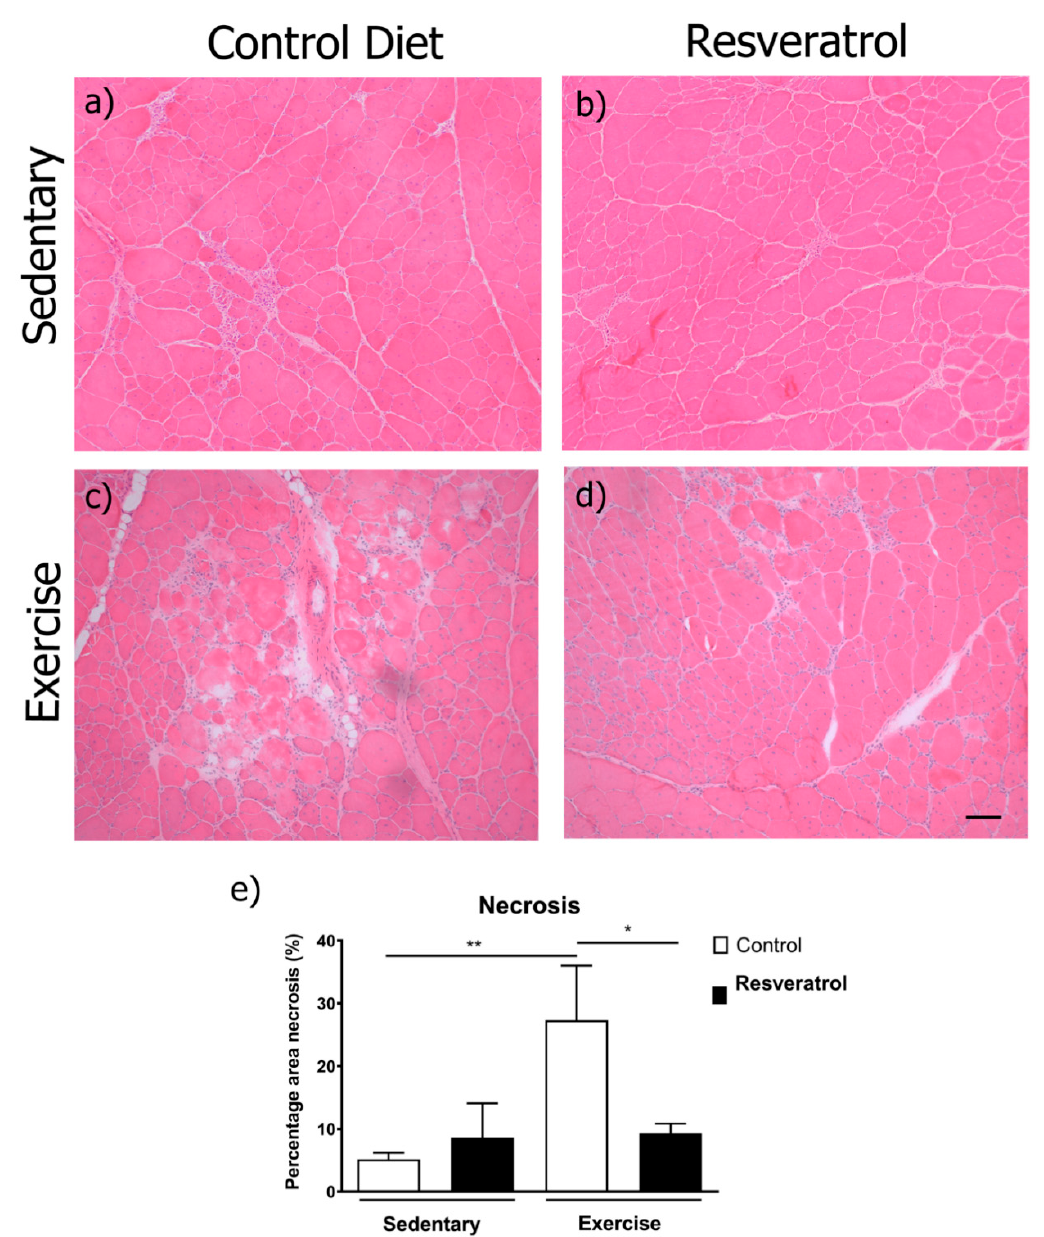
Figure 3. Transverse quadriceps sections were stained with haemotoxylin and eosin to illustrate muscle architecture, areas of inflammation and fibrosis. ( a ) Representative image of an mdx control diet sedentary quadriceps, ( c ) an mdx control diet exercise quadriceps, ( b ) a resveratrol treated sedentary mdx quadriceps and ( d ) an mdx resveratrol treated exercised quadriceps. ( e ) Areas of necrosis were quantified and expressed as a percentage of the total quadriceps area. Necrosis was not different with resveratrol treatment in the sedentary mdx . Voluntary exercise significantly increased necrosis. This effect is not observed in the resveratrol treated mice when comparing sedentary with exercised resveratrol treated mice. The black scale bars represent 100 µ m. Graphs show mean ± SEM. * indicates p < 0.05, ** p < 0.01. n = 5 for each treatment group.